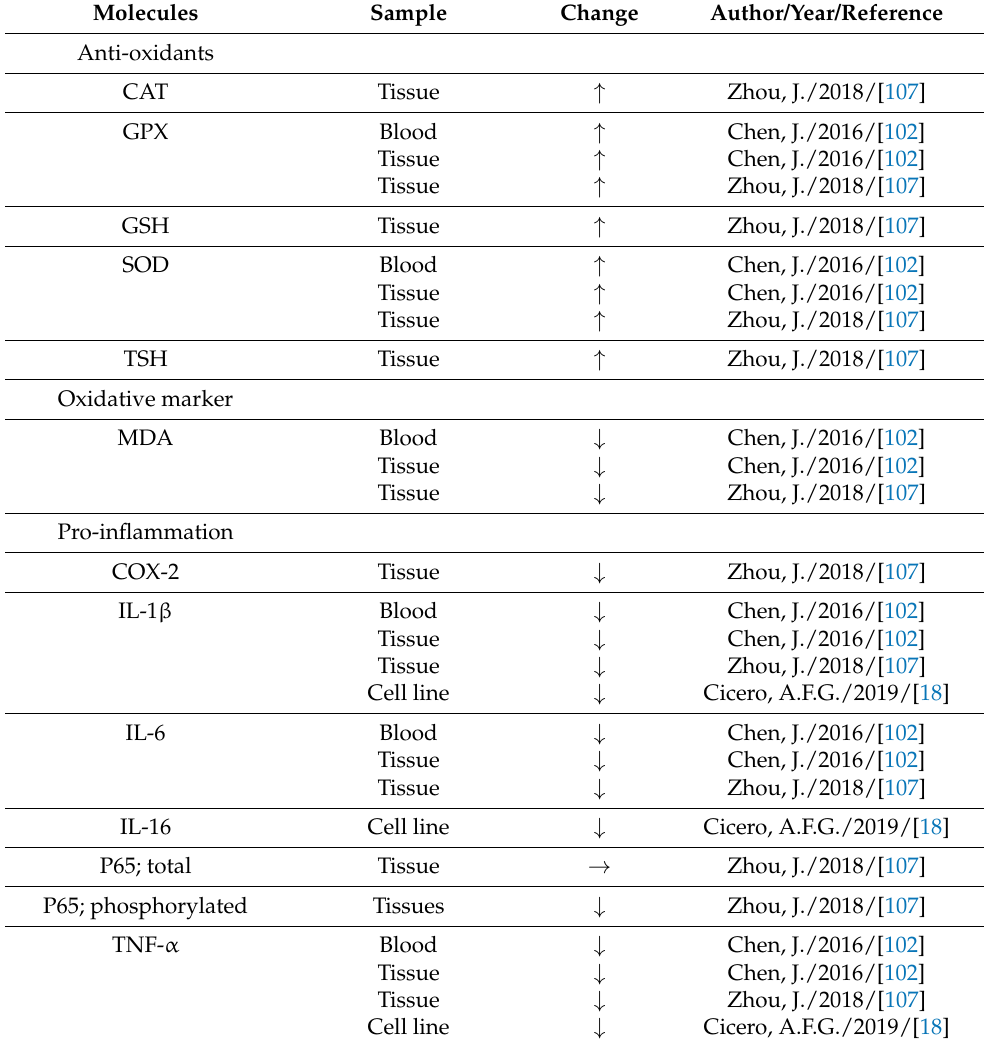
Table 1. Change of oxidative stress- and inflammatory-related molecules by green tea